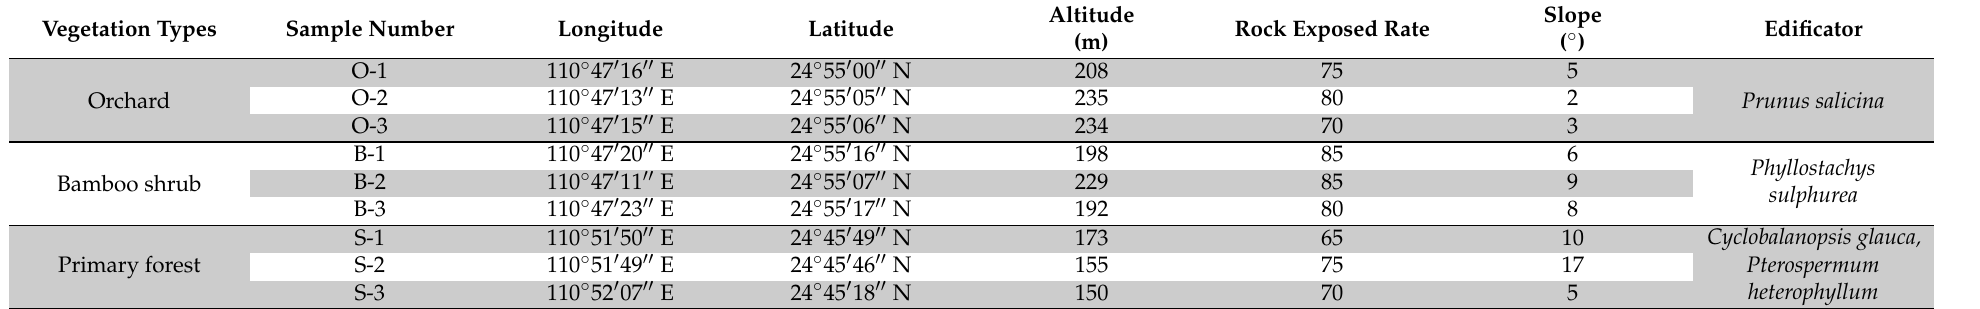
Table 1. Sample plot